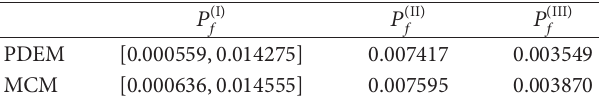
Table 1: The reliability indices of Example